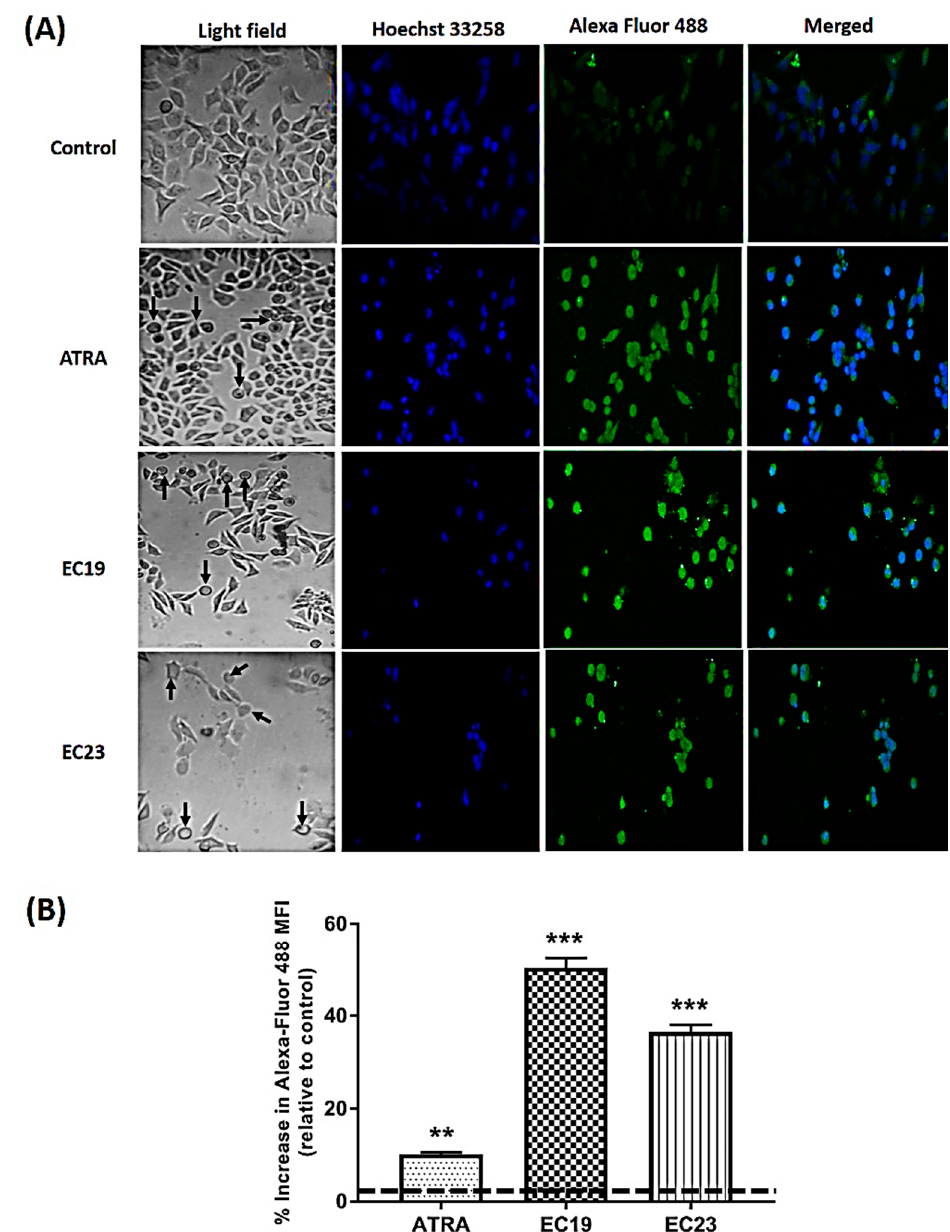
Figure 10. Cell morphology and immunocytochemistry of Caco-2 cells treated with IC 50 of retinoids for 24 h and stained with anti-Cytochrome-C antibody. ( A ) Control Caco-2 cells treated with 0.1% DMSO was compared to those treated with retinoids under an inverted microscope (OPTECH Biostar IB; magnification, 40 × ). Dark arrows indicate rounded apoptotic bodies. ( B ) Also, a comparative assessment of anti-Cytochrome-C staining of control cells, compared to cells treated with ATRA, EC19 and EC23, was performed. The most significant increase in Cytochrome-C protein expression level was demonstrated in EC19-treated cells followed by EC23 treatment and finally ATRA treatment in comparison to DMSO-treated control cells. The values were considered statistically significant in comparison to untreated control at ** p < 0.01, *** p < 0.001. Results are expressed as the mean ± SEM ( n = 3).